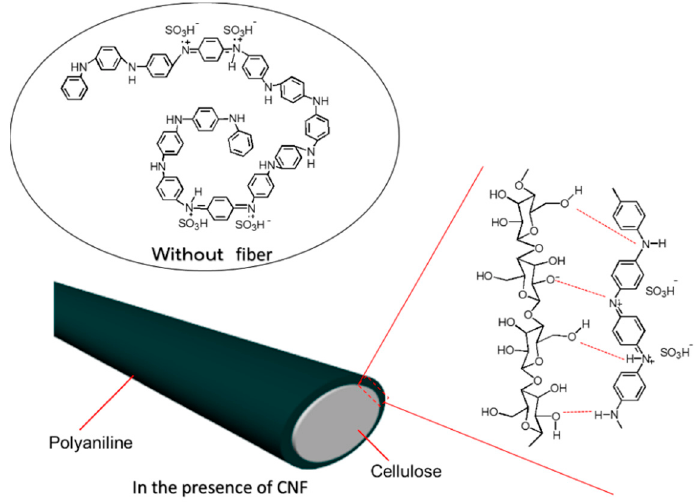
Figure 6. Plausible structure and polymerization mechanism without fiber ( upper ) and on the CNF ( lower